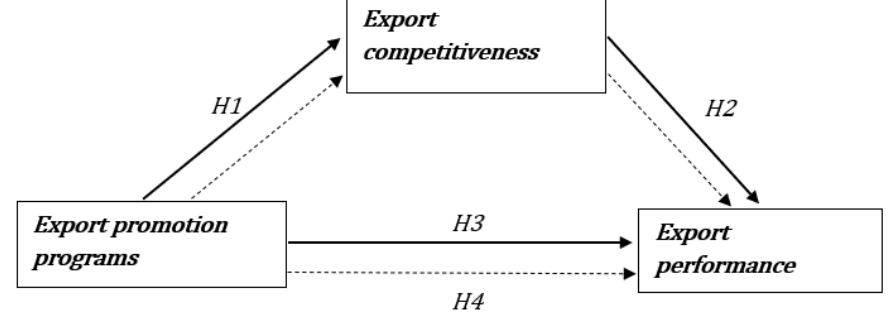
Figure 1. Conceptual Framework.